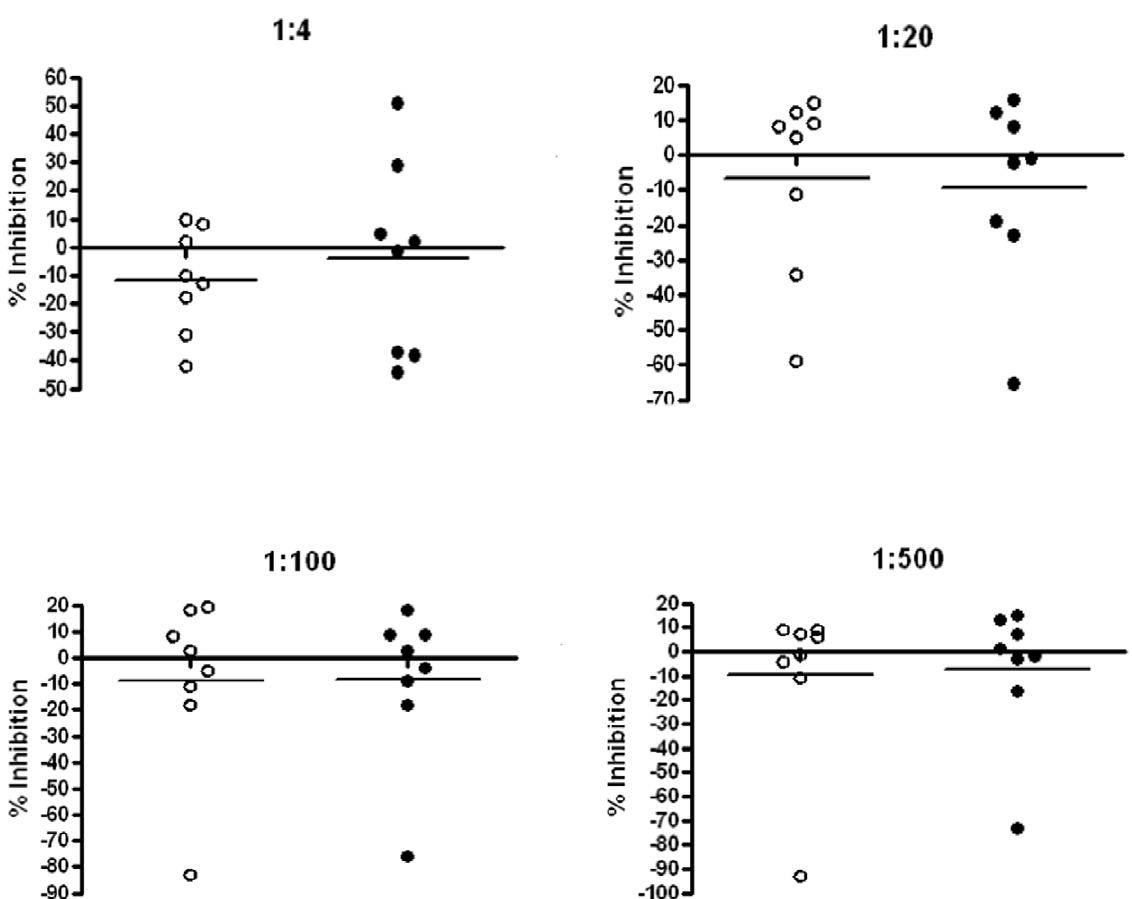
Figure 4. Enhancement of cell-associated HIV-1 infection by breast milk. Breast milk from HIV-positive and HIV-negative donors was evaluated for activity against cell-associated HIV-1 infection in TZM-bl cell assays. Breast milk was tested at 5-fold serial dilutions (1:4, 1:20, 1:100 and 1:500). Percent inhibition or enhancement of cell-associated R5 HIV-1 BAL is shown for breast milk samples from individual HIV-positive (open circles) and HIV-negative (closed circles) donors.